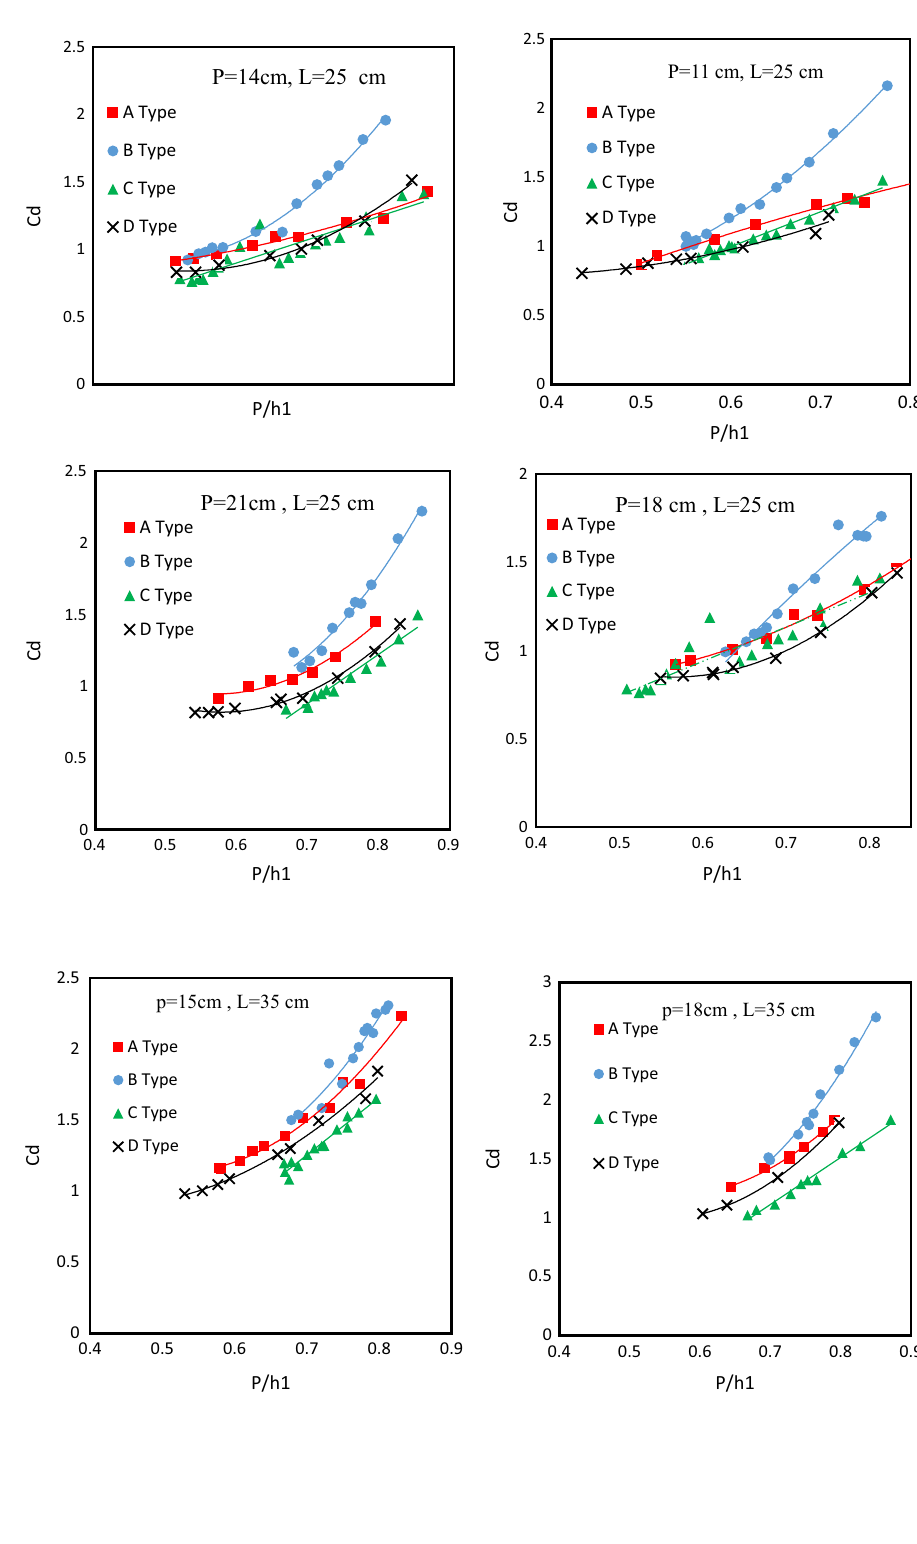
Fig. 8 Variations of discharge coefficient of RPKSW vs. the ration of P / h 1 with L = 35